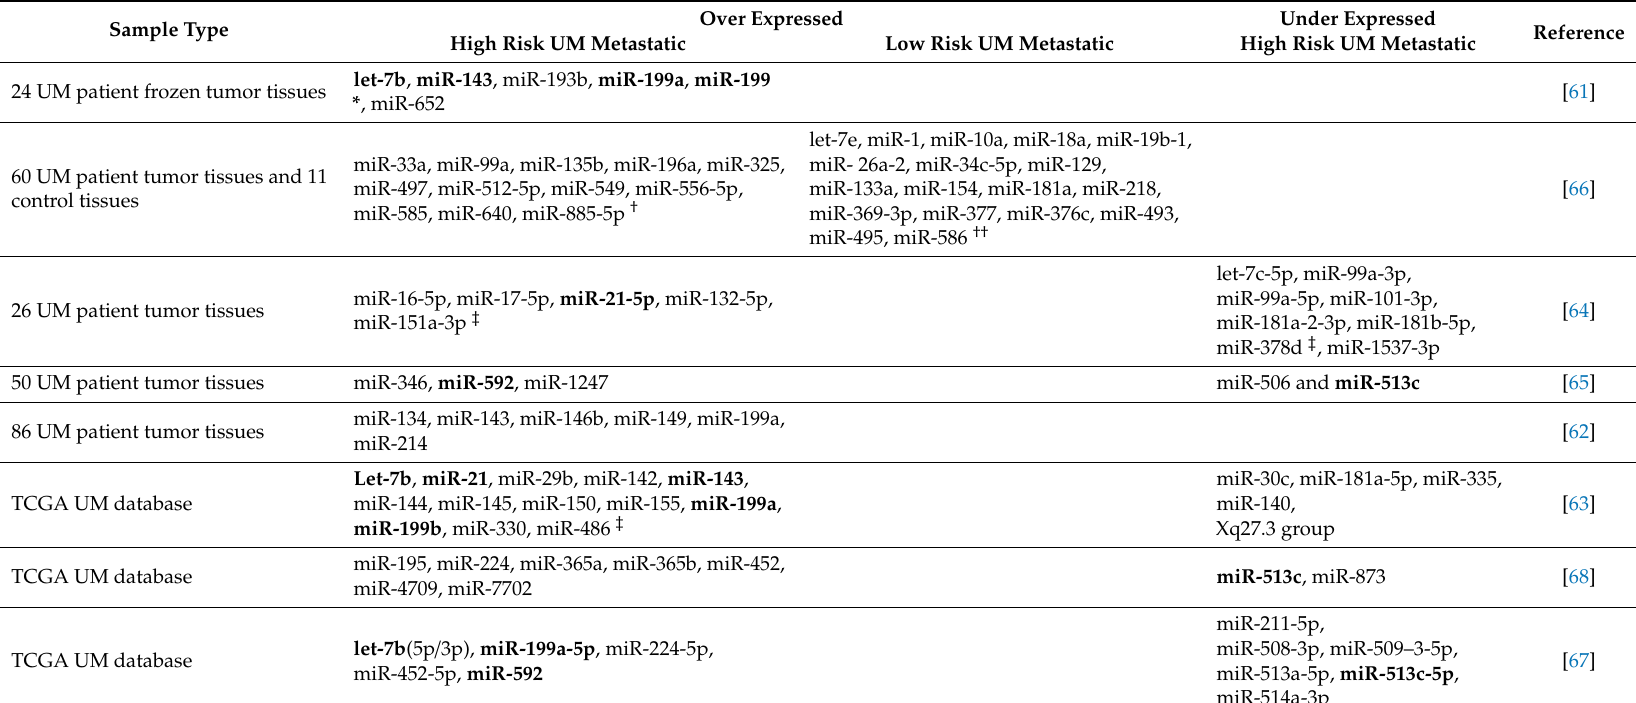
Table 3. miRNAs in association with an increased risk of uveal melanoma